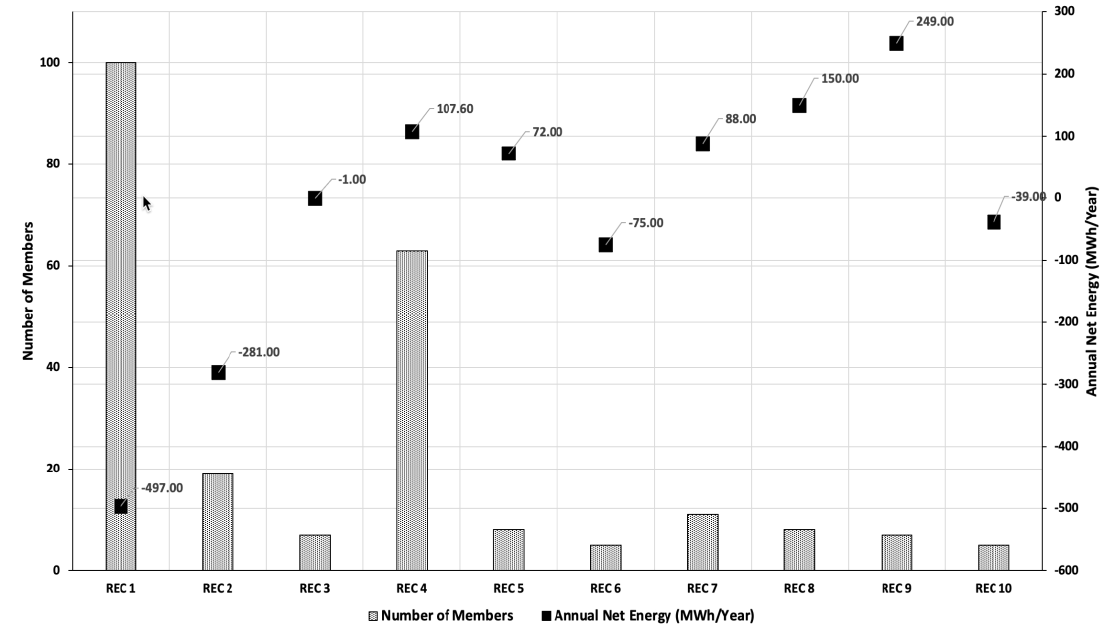
Figure 23. Number of members and annual net energy by REC — single-link.